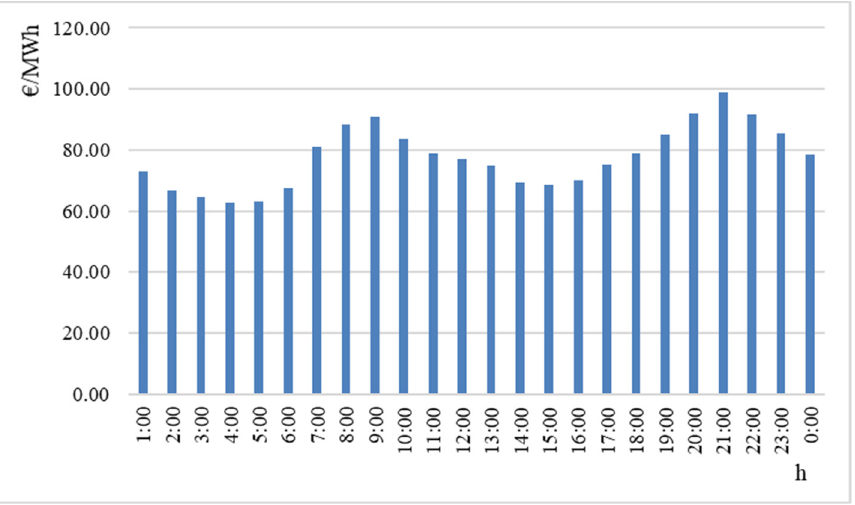
Figure 6. HUPX’s electricity price diagram for the chosen optimization period (9 June 2021). Table 6. Data for case 1: Gaag, Netherlands.